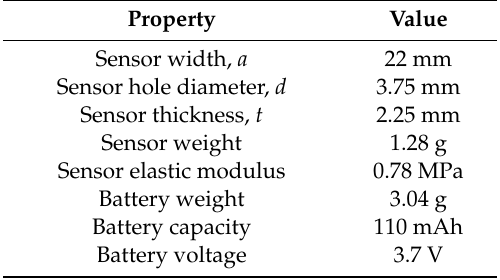
Figure 3. StretchSense pressure sensor, wireless measurement circuit, and battery. Table 1. StretchSense pressure sensor and measurement equipment